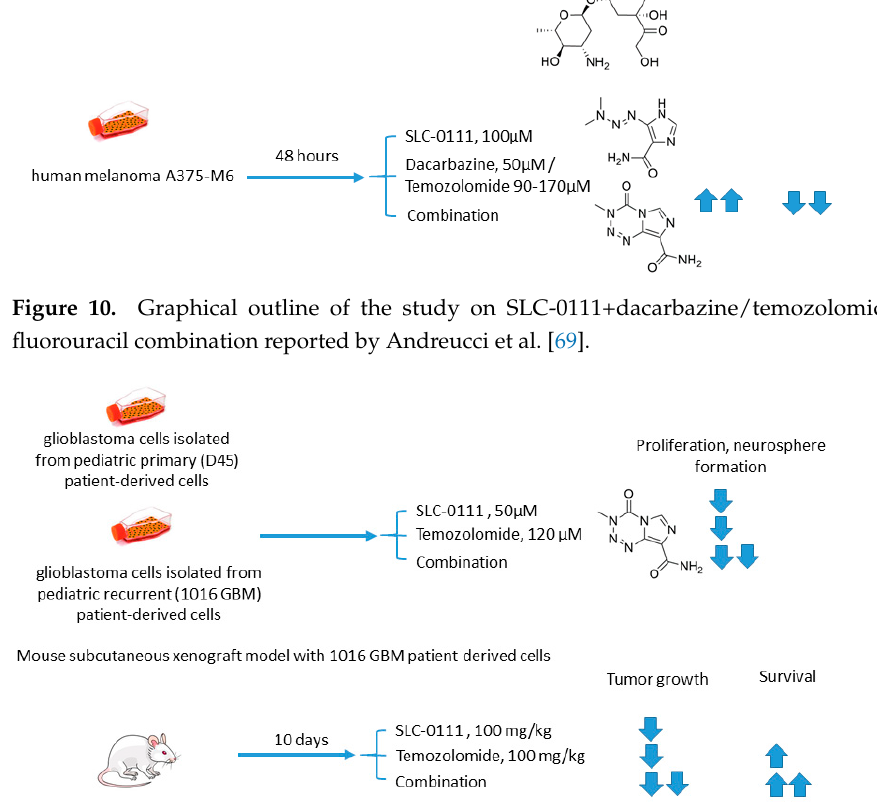
Figure 11. Graphical outline of the study on SLC-0111+temozolomide combination reported by Boyd et al.